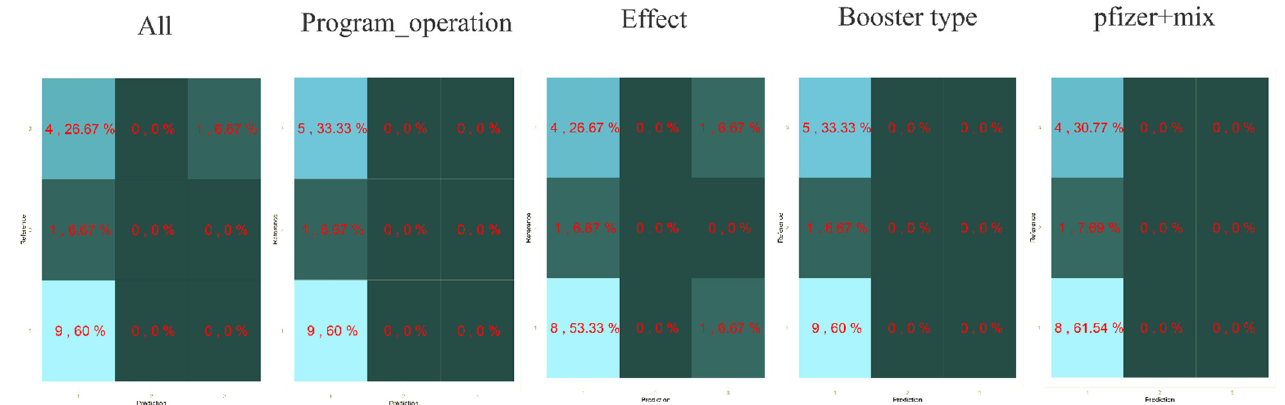
Figure 12. Confusion